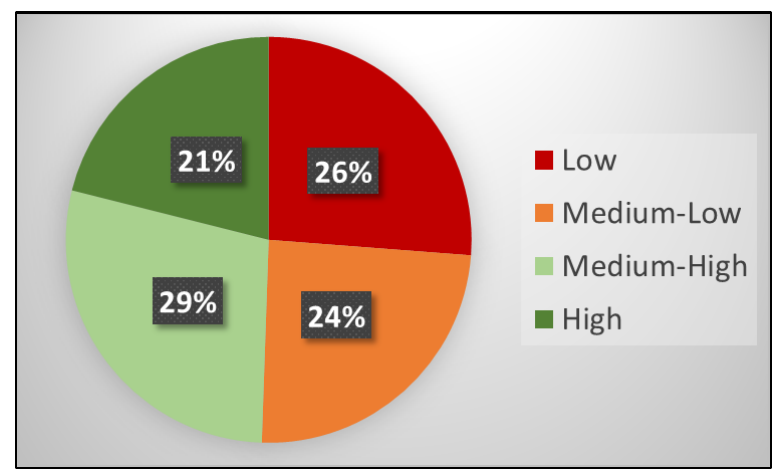
Figure 9. Hotel Guests’ Energy-Use Behavior Motivation Level.